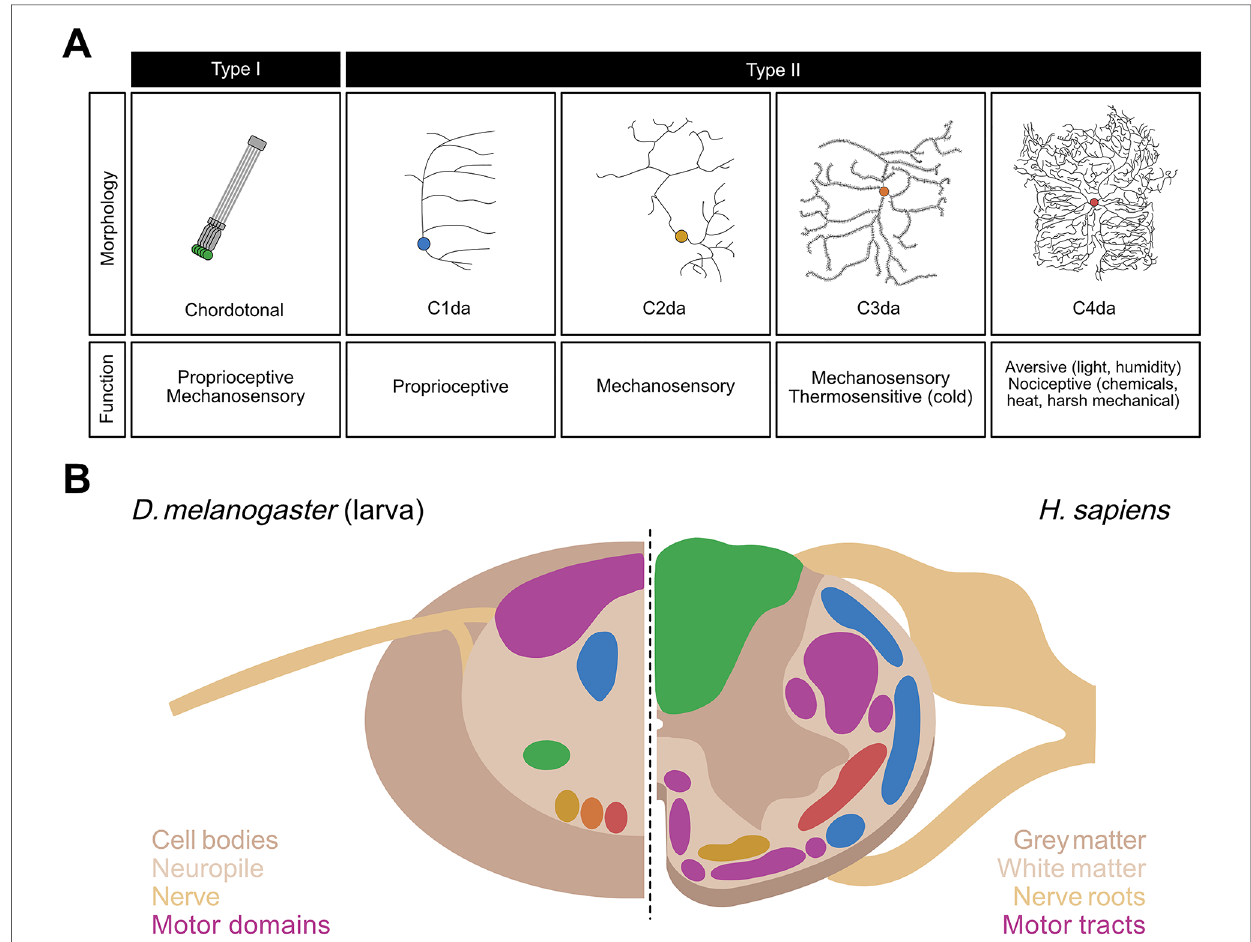
FIGURE 1 Neurons of the somatosensory system and structural organization of the ventral nerve cord (VNC) in Drosophila larvae. ( A ) Morphology and function of the somatosensory neurons in larval Drosophila melanogaster . Chordotonal (green), C1da (blue), C2da (yellow), C3da (orange), and C4da (red) neurons are contrasted in terms of their neural morphologies and sensory functions. ( B ) Side-by-side comparison of a sagittal section of the VNC in D. melanogaster larvae (left) with that of the spinal cord in Homo sapiens (right). Spatially distinct colored regions on the left (green, blue, yellow, orange, and red) represent those occupied by the fi ve classes of Drosophila larval sensory neurons shown in corresponding colors in ( A ). Colored regions on the right represent those in the human spinal cord occupied by sensory neurons whose functions closely correspond to their counterpart neurons in Drosophila larvae, i.e., proprioceptive tracts (blue), fi ne touch tracts (yellow), tracts carrying mechanosensory and proprioceptive information (green), and nociceptive tracts (red). In both species, motor regions (purple) are spatially segregated from the sensory